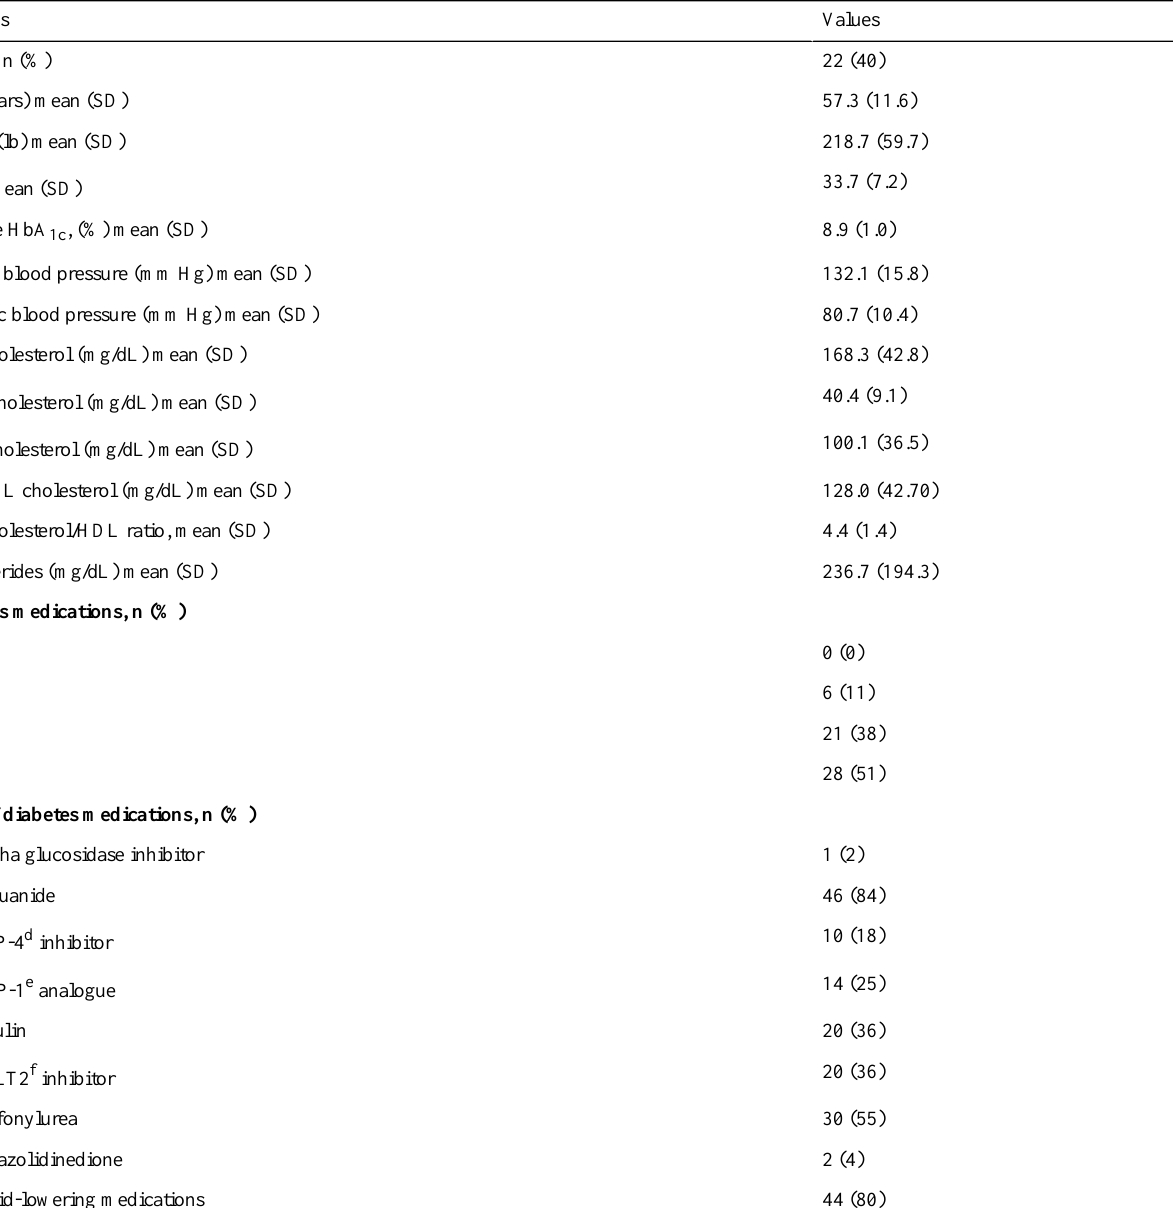
Table 1. Participant demographics at baseline.